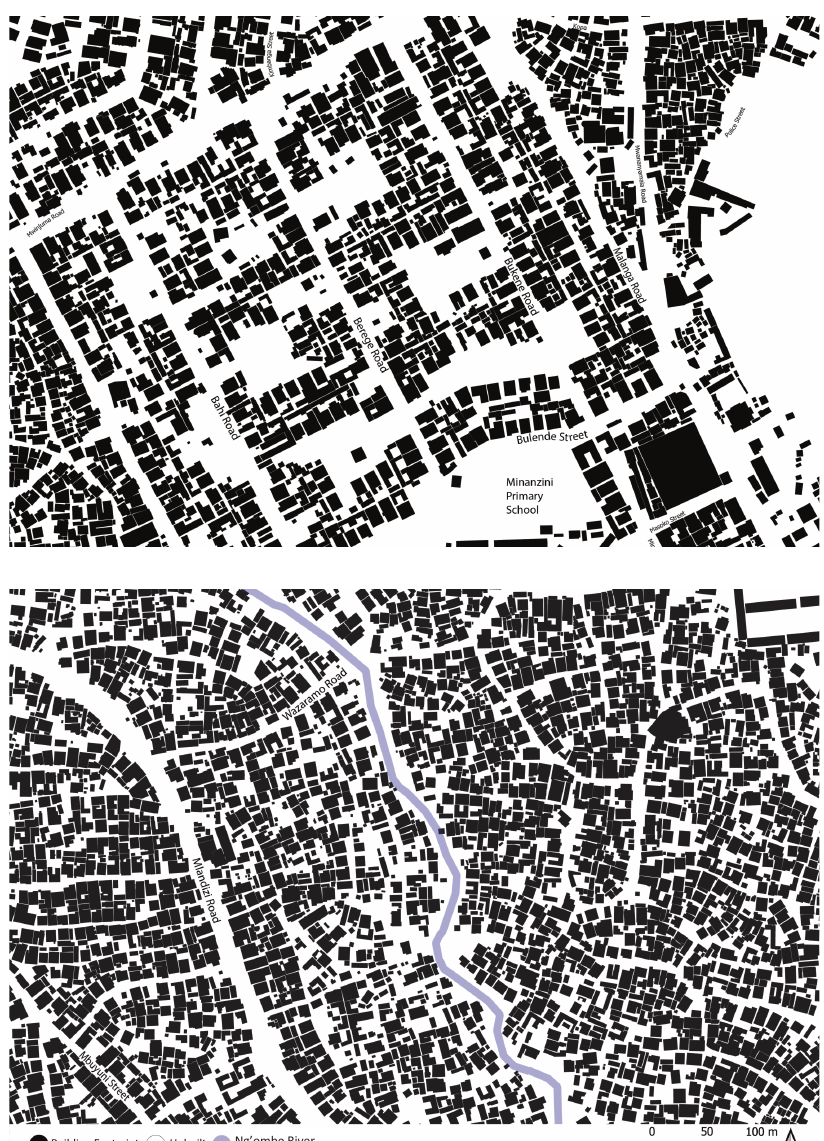
Figure 5. Urban form and built‐up areas of Mwananyamala (top) and Tandale (bottom). Source: Courtesy of Lerys